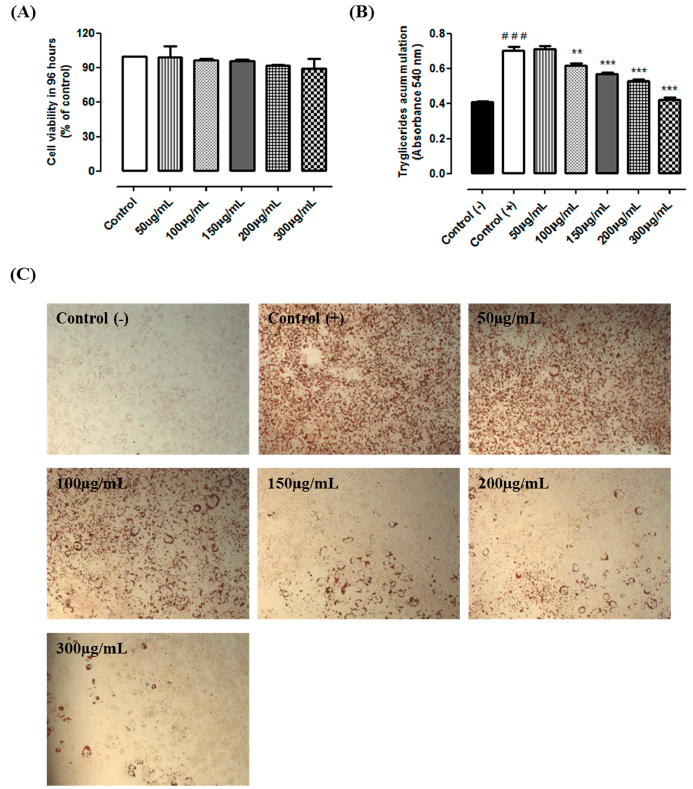
Figure 1. ( A ) Cell viability evaluated through MTT assay. Control—cells cultivated with DMEM; 50 µg/mL, 100 µg/mL, 150 µg/mL, 200 µg/mL and 300 µg/mL—cells cultivated with DMEM + guarana in different concentrations; ( B ) Triacylglycerol accumulation in 3T3-L1 cells according to Oil Red O assay. Negative control (C − )—cells cultivated with DMEM; Positive control (C+)—cells cultivated with differentiation medium (DMEM supplemented with 10% fetal bovine serum, 1% of penicillin/streptomycin/glutamine, 0.01% of dexamethasone (1 mM), 0.01% of insulin (100 UI) and 0.1% of IBMX (0.5 mM)) and 50 µg/mL, 100 µg/mL, 150 µg/mL, 200 µg/mL and 300 µg/mL—cells cultivated with differentiation medium + guarana in different concentrations. ### p < 0.0001 compared with C ( − ) and ** p < 0.001 and *** p < 0.0001 compared to C (+) group; ( C ) Illustrative images of Oil Red O in 3T3L1 cells (magnification = 200 ×